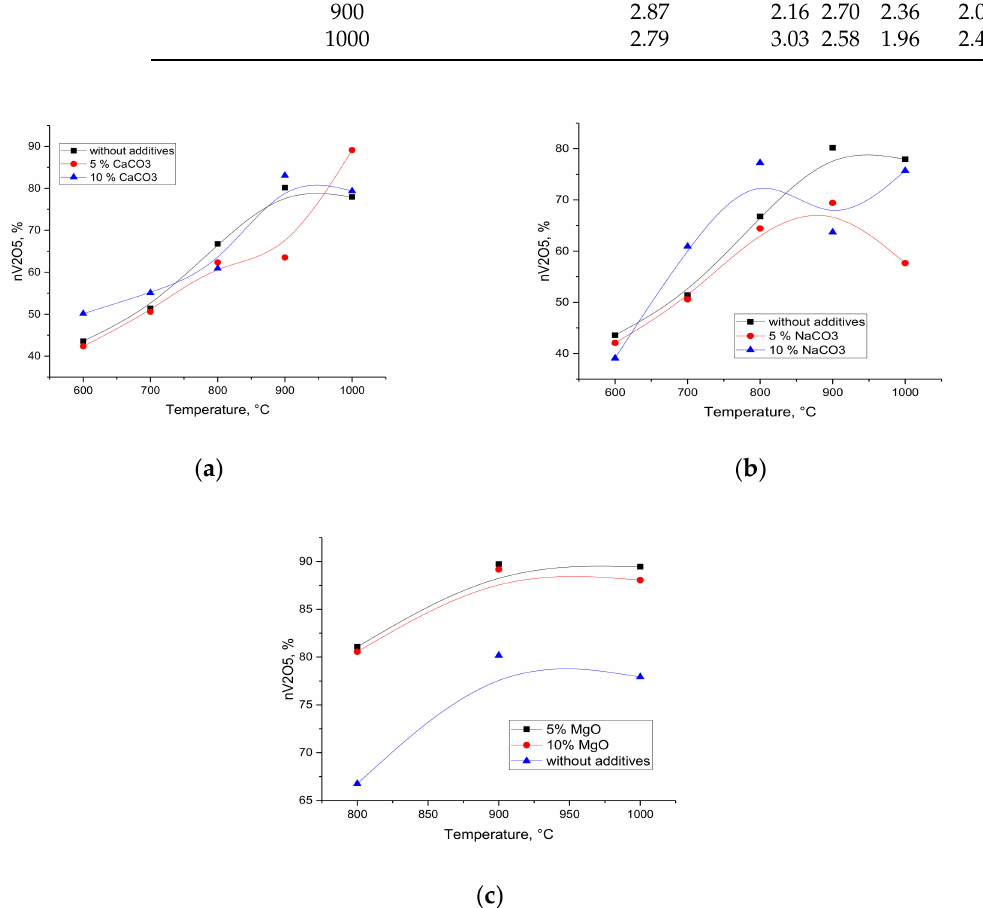
Figure 1. Effect of roasting temperature and additive amount on η V2O5 with additives CaCO 3 ( a ), Na 2 CO 3 ( b ) and MgO ( c ) . Experimental curves were processed by the B-spline (basis spline)